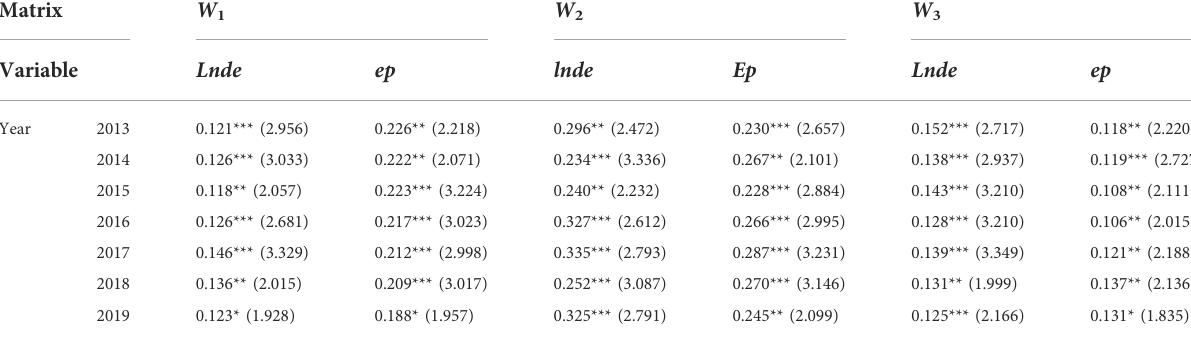
TABLE 5 Global Moran index of digital economy and ecological performance (2013 – 2019).